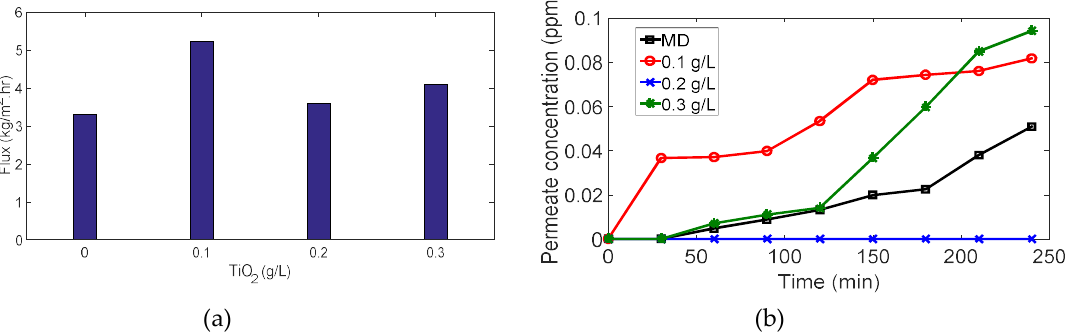
Figure 14. Results for 15 ppm MB experiments: ( a ) flux vs. amount of TiO 2 ; ( b ) permeate concentration vs. time